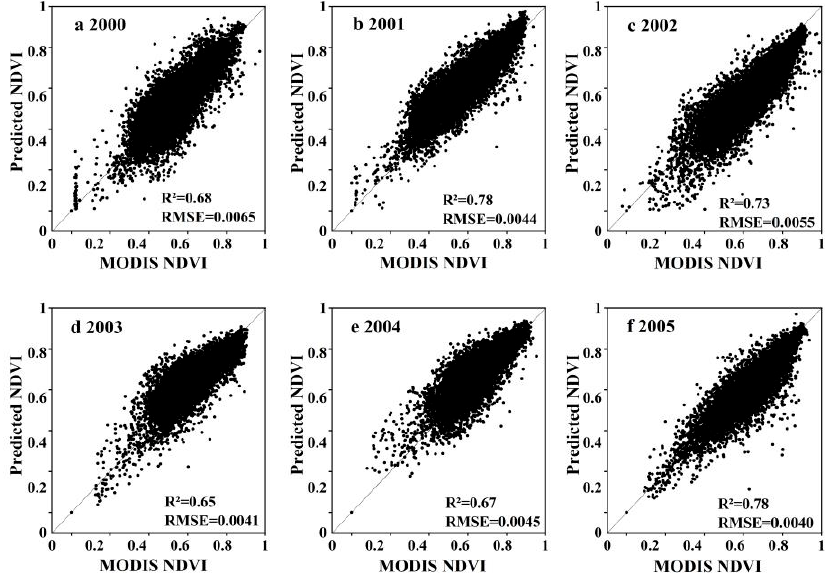
Figure 5. Linear regression between the ESTARFM-predicted NDVI and MODIS NDVI in the entire study area. The p -values of hypothesis tests in each year are all < 0.01.